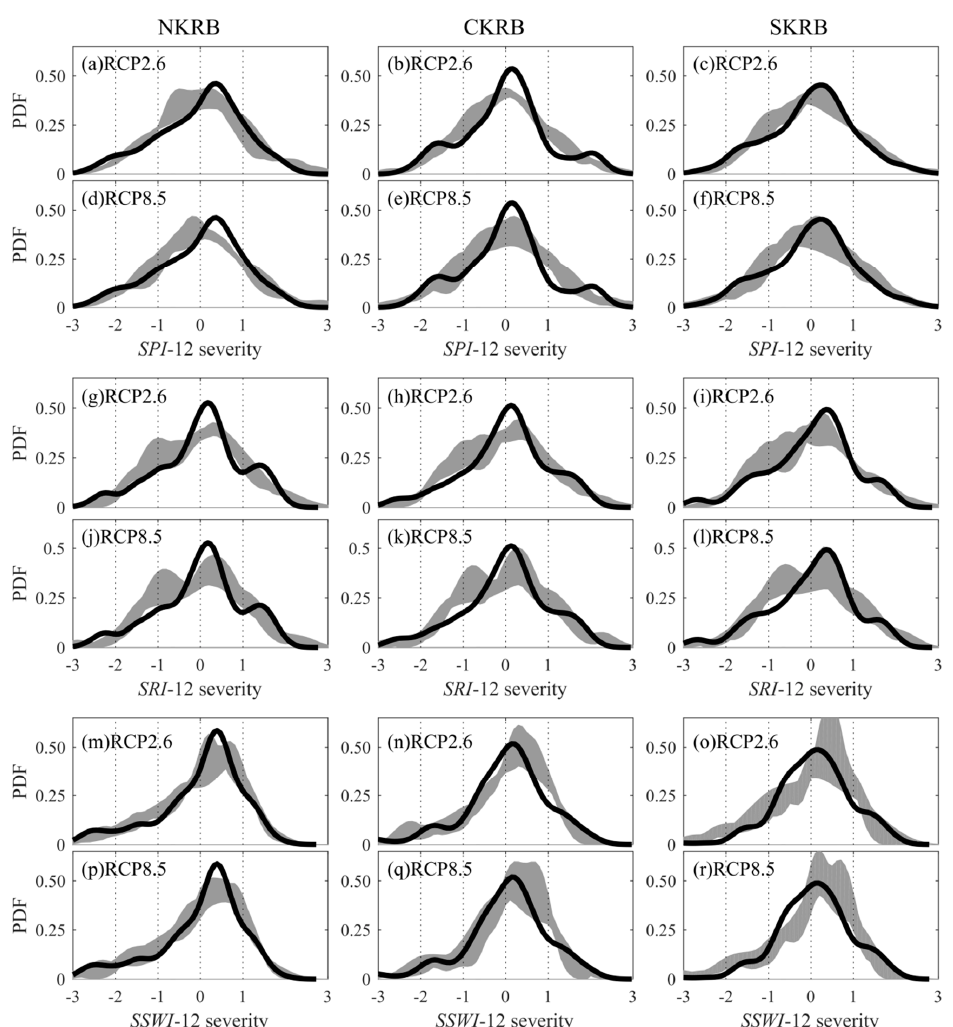
Figure 3. The probability density function (PDF) of different severities of SPI -12 ( a – f ), SRI -12 ( g – l ), and SSWI- 12 ( m – r ) in RCP2.6 and RCP8.5 scenarios. The grey bands are extracted from maximum and minimum values in the five GCMs and the black lines indicate the historic PDFs.